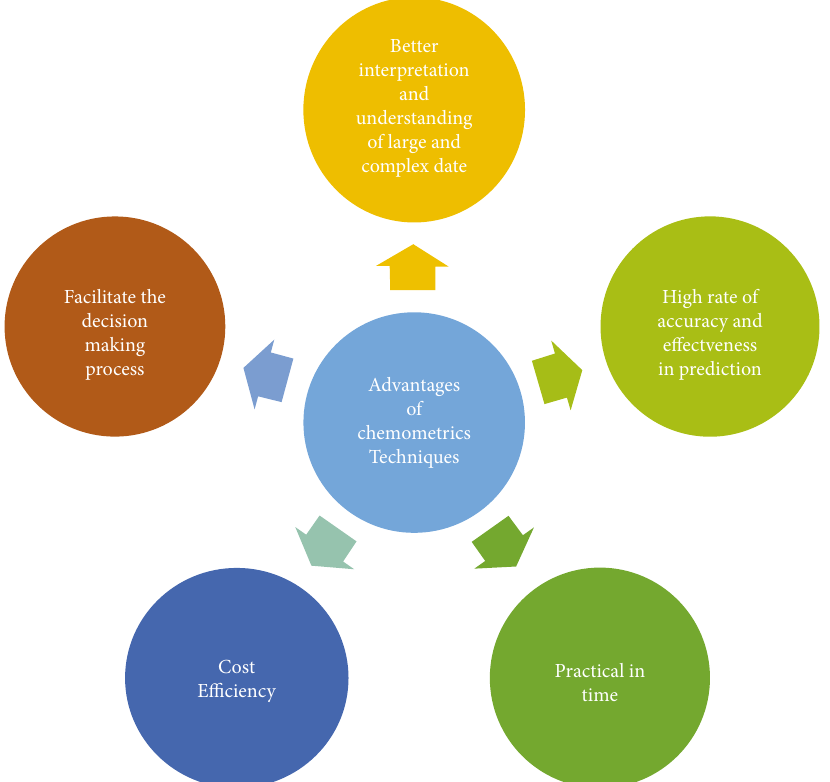
Figure 1: Shows advantages of the chemometric method.